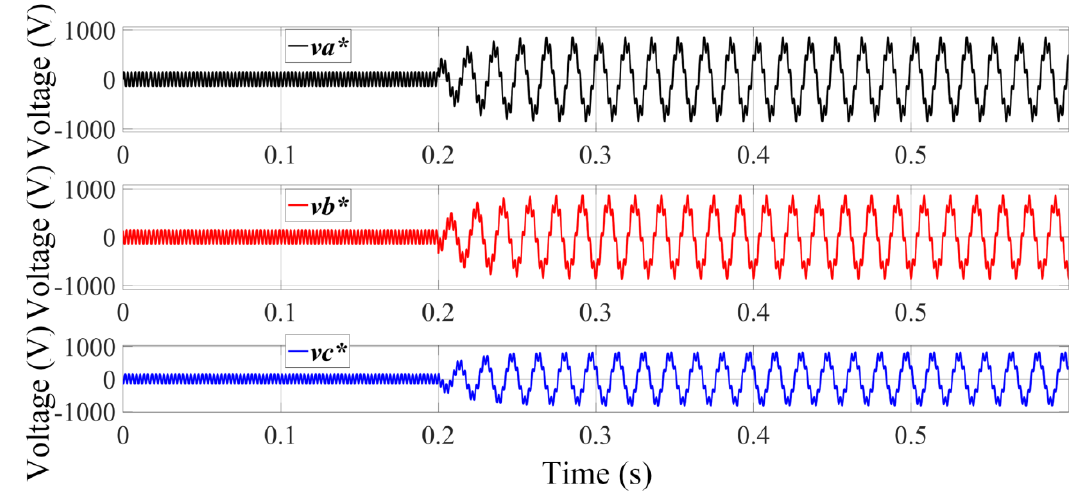
Figure 19. Seventh order harmonic with 3% added to the fundamental frequency of reference voltages in phases a (black), b (red), and c (blue). Vertical axis: 1 kV/div. Horizontal axis: 100 ms/div.